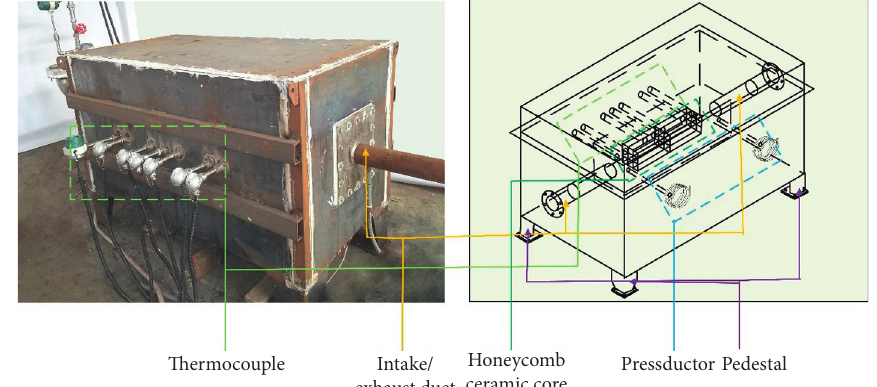
Figure 2: Combustor physical and structural diagram.